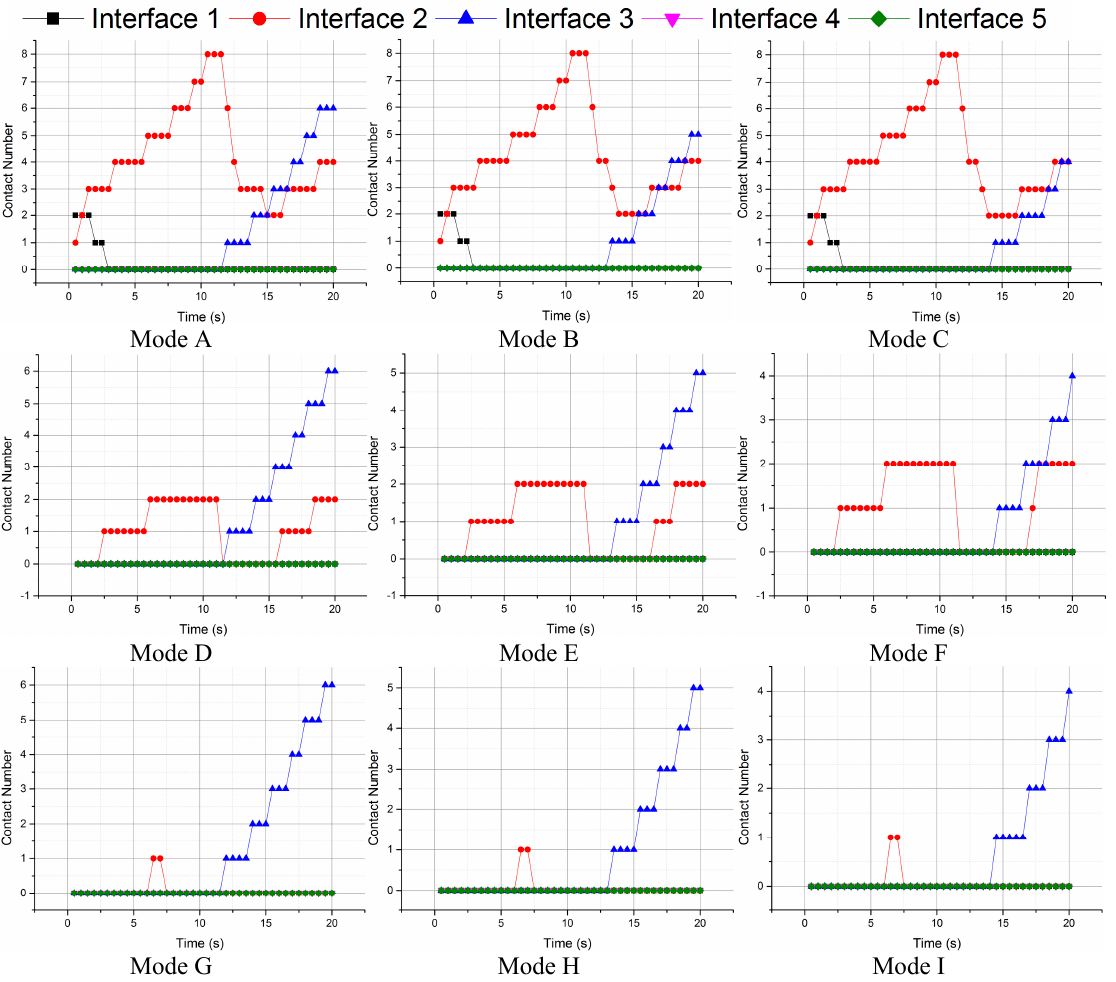
Figure 14. Contact number history of the nine selected modes.